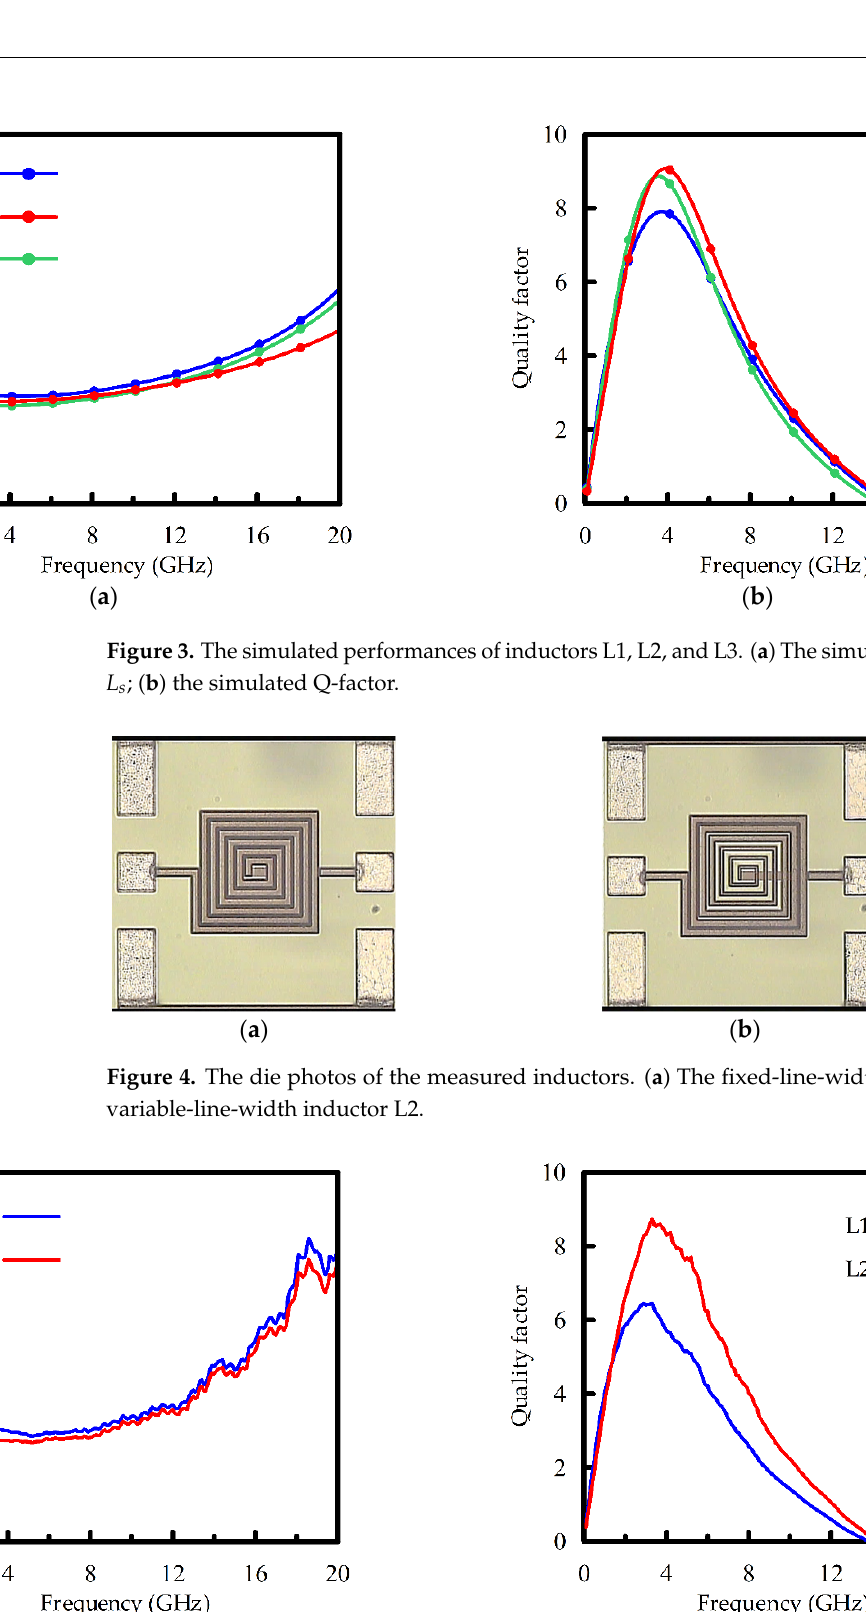
Figure 4. The die photos of the measured inductors. ( a ) The fixed-line-width inductor L1; ( b ) the variable-line-width inductor L2. Figure 5. The measured performances of inductors L1 and L2. ( a ) The measured series inductance L s ; ( b ) the measured Q-factor. Table 3. A comparison of the performances of inductors L1 and L2 at typical frequencies.